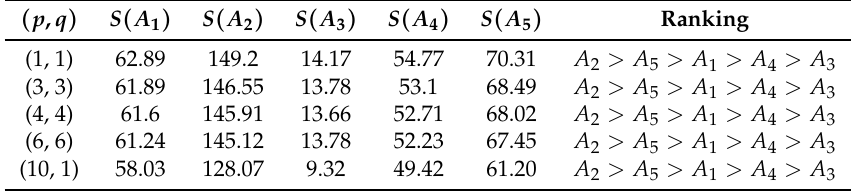
Table 10. Liu and Li’s method [6] (ranking for different parameters of the normal neutrosophic weighted geometric Bonferroni mean (NNWGBM)).